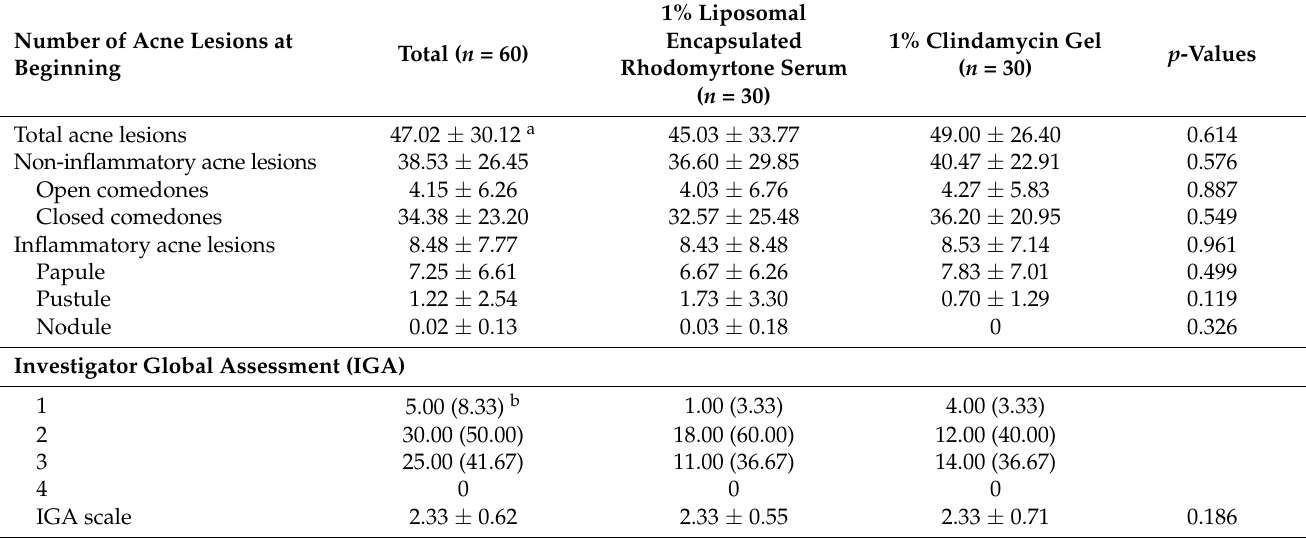
Table 2. Quantity of acne lesions and Investigation’s Global Assessment (IGA).